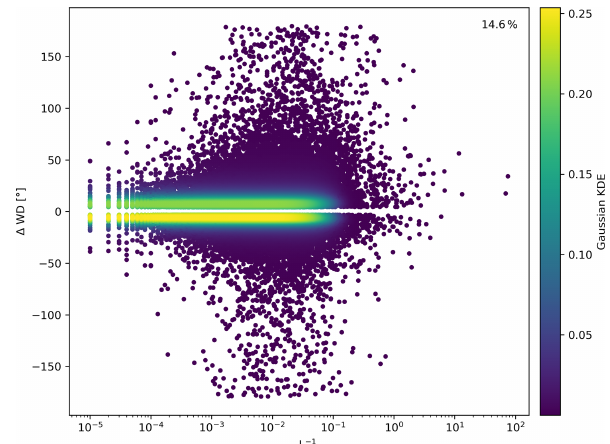
Figure 6. Wind direction difference ( (cid:49) WD) at the inter-cluster scale (DBU and GT I) for neutral and stable atmospheric stratifica- tions. Only values for wind speeds above 2.5ms − 1 and (cid:49) WD ex- ceeding the lower and upper quartiles are shown, which results in 14.6% of the data. The color shows a Gaussian kernel density esti- mation